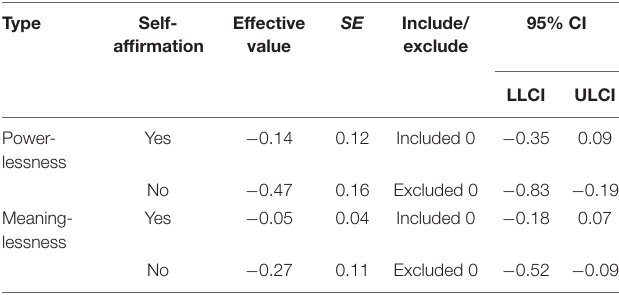
TABLE 2 | Moderation of self-affirmation on the mediating effect of powerlessness and